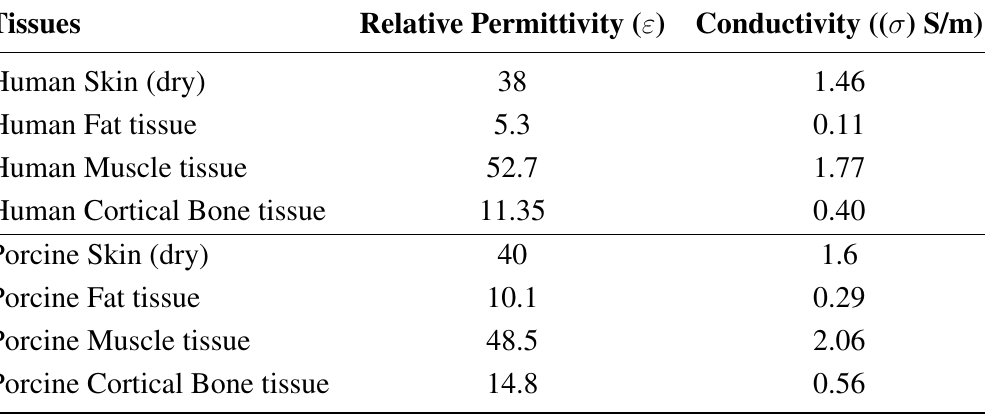
Table 2. Electrical properties of human and porcine tissues at 2.4